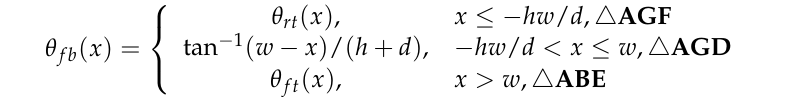
For a single scan from a location x , the number of points on the far wall, n (cid:48)